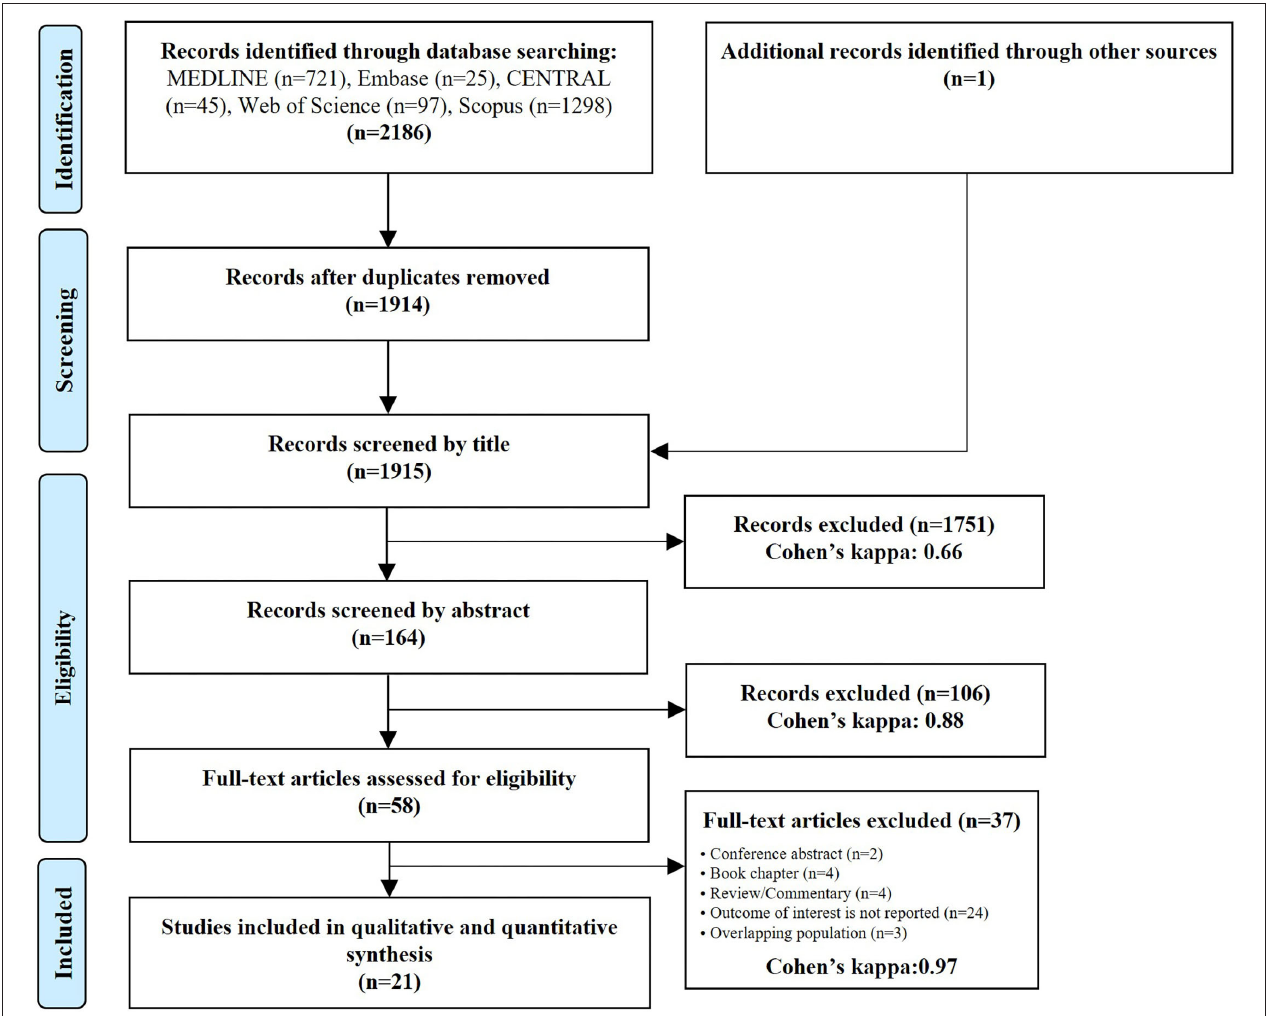
FIGURE 1 | PRISMA flowchart of study